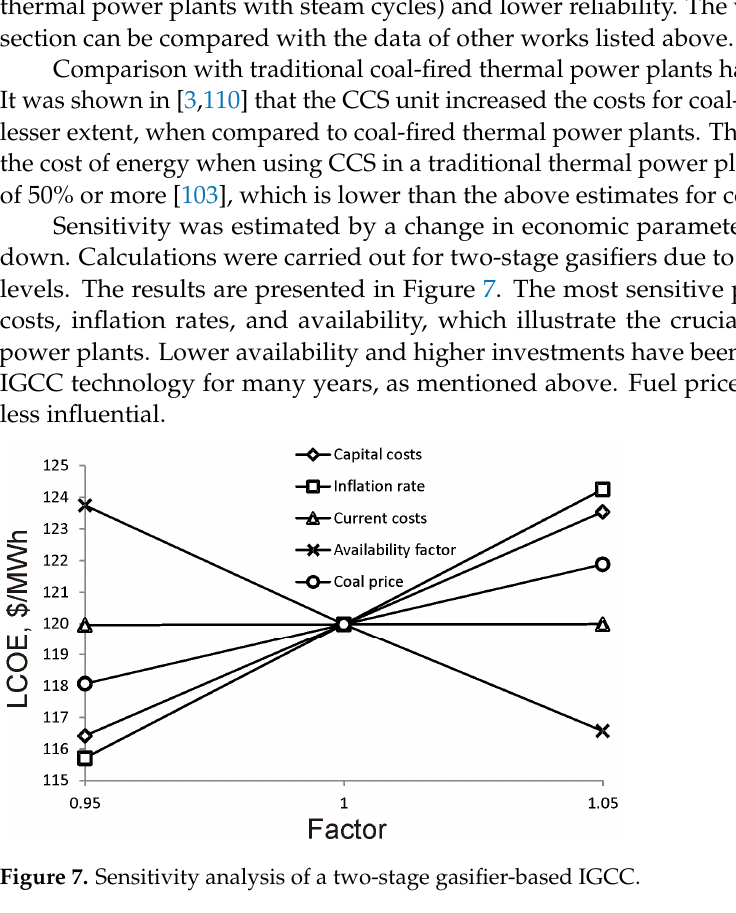
Figure 6. Dependence of the technical and economic indicators of coal-fired IGCC plants on the fuel gasification process: net efficiency ( a ) and cost of energy ( b ). The columns for the basic scheme are grey, and the columns for the CCS schemes are white.